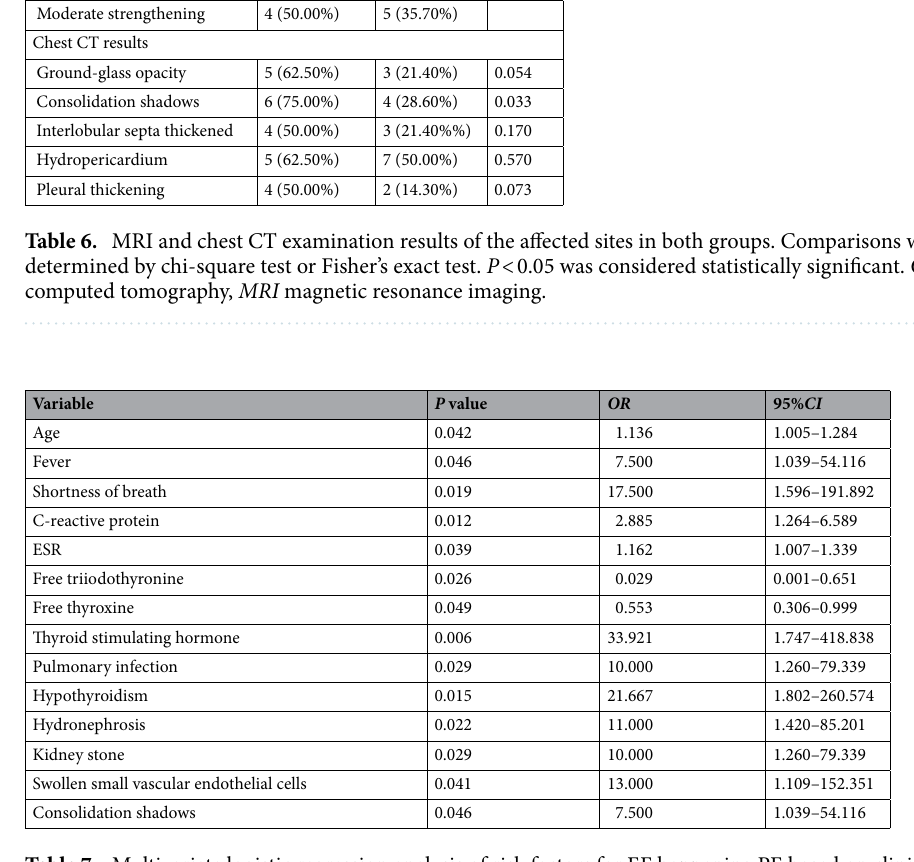
Table 7. Multivariate logistic regression analysis of risk factors for EF happening PE based on clinical parameters and sociodemographic characteristics. Values were expressed as odds ratio (OR) and 95% confidence interval (CI). Risk factors associated with EF-PE were determined by multivariate logistic regression analysis. P < 0.05 was considered statistically significant. ESR erythrocyte sedimentation rate, 95% CI 95% confidence interval, OR odds